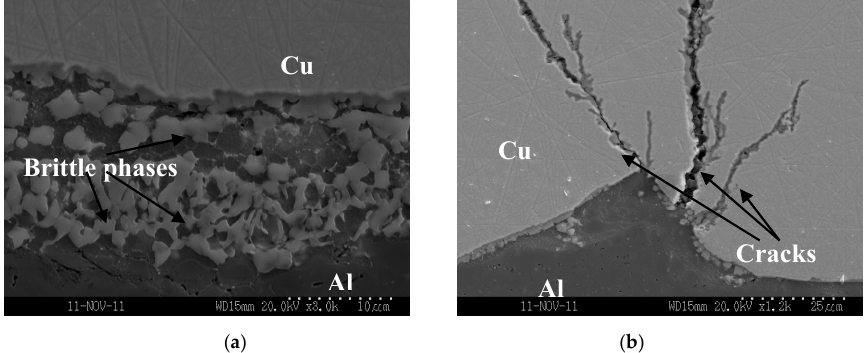
Figure 6. ( a ) Brittle phases and ( b ) Cracks defect of the Al/Cu ultrasonic welded joint.